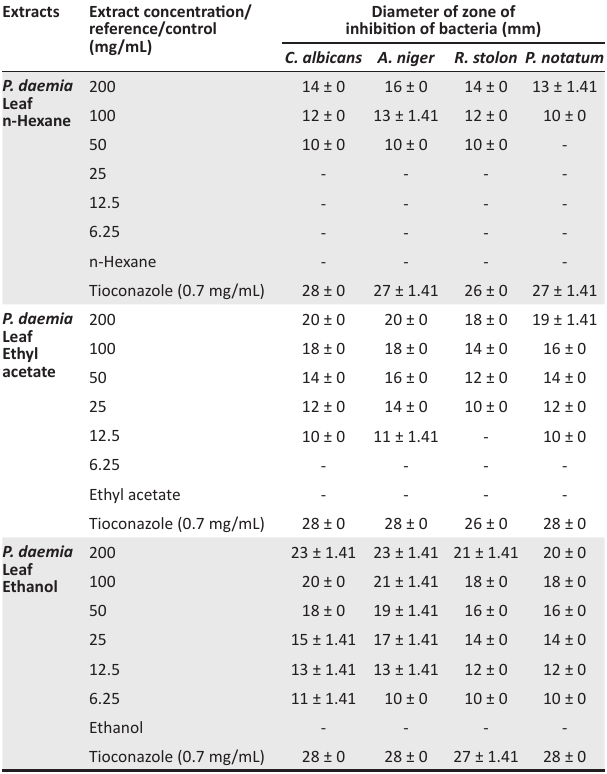
Diameter of zone of inhibition of bacteria